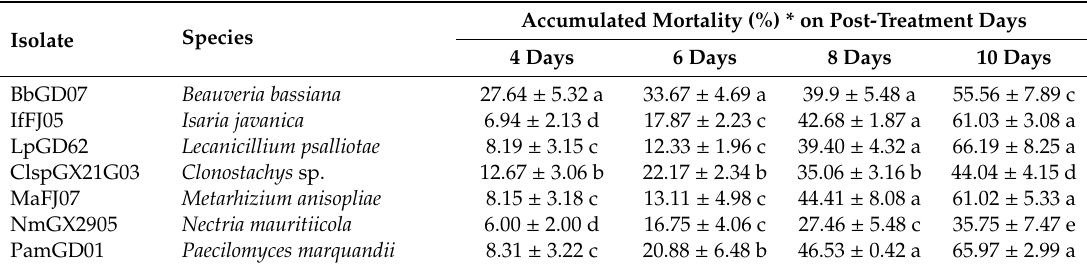
Table 4. The pathogenicities of fungal isolates against the second nymphs of the B-biotype